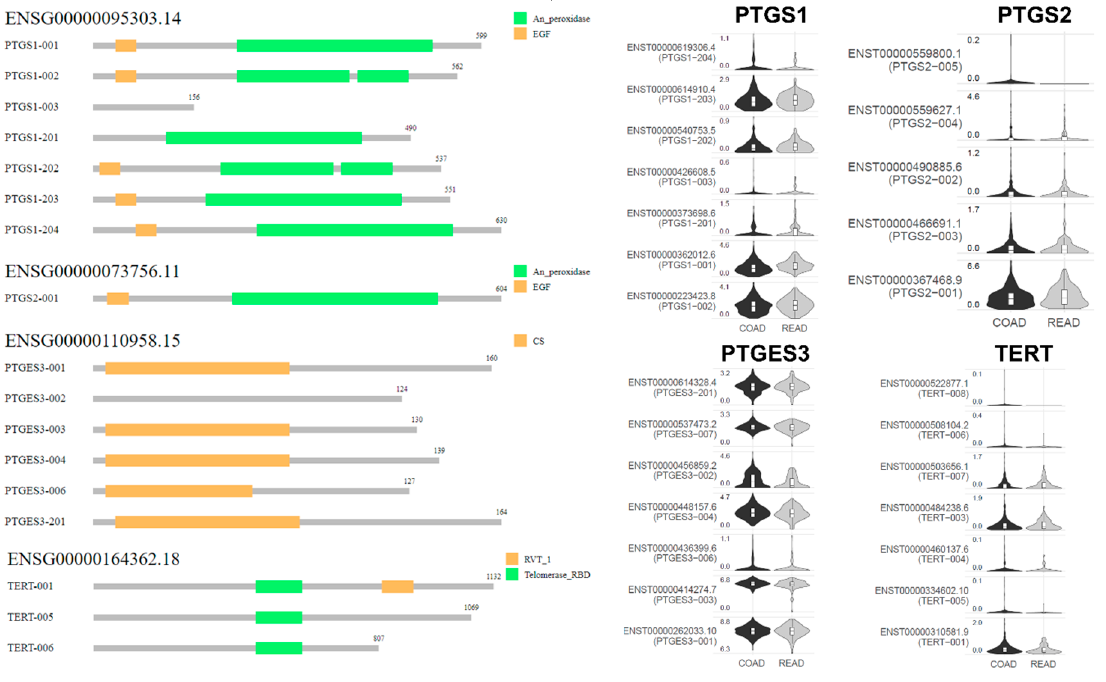
Figure 5. Isoform structural analysis shows that the differential expression of specific transcripts is related to the expression of the COX-1 (ENSG00000095303.14; PTGS1), COX-2 (ENSG00000073756.11; PTGS2), COX-3 (ENSG00000110958.15; PTGES3), and TERT (ENSG00000164362.18) genes